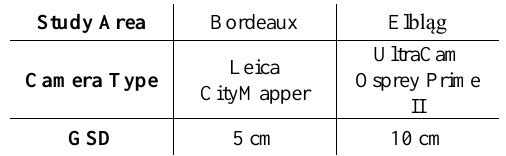
Table 1. Summary of characteristics of the used image datasets.